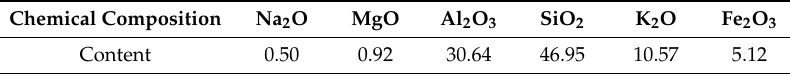
Table 1. Chemical composition of pure minerals (wt